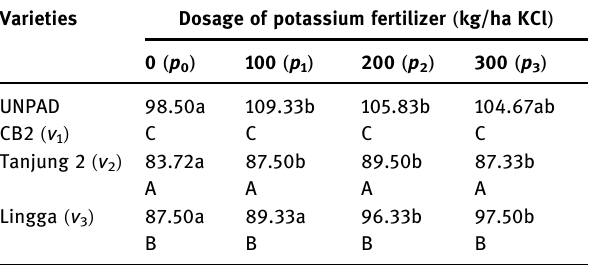
Varieties Dosage of potassium fertilizer ( kg/ha KCl )